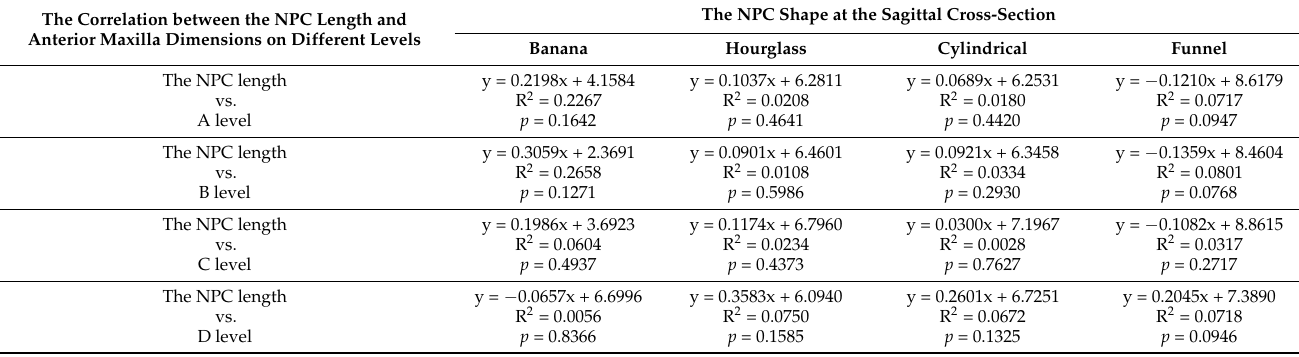
Table 6. The correlation between the nasopalatine canal length and anterior maxilla dimensions at predefined portions depending on the canal shape at the sagittal